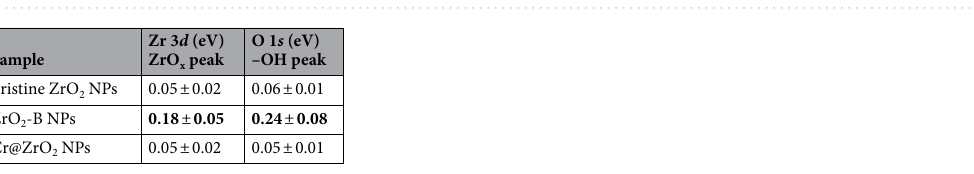
Figure 5. In situ X-ray photoelectron spectra of ( a ) ZrO 2 , ( b ) ZrO 2 -B, and ( c ) Cr@ZrO 2 NPs recorded with (red) and without (black) UV light irradiation ( λ ≥ 225 nm).